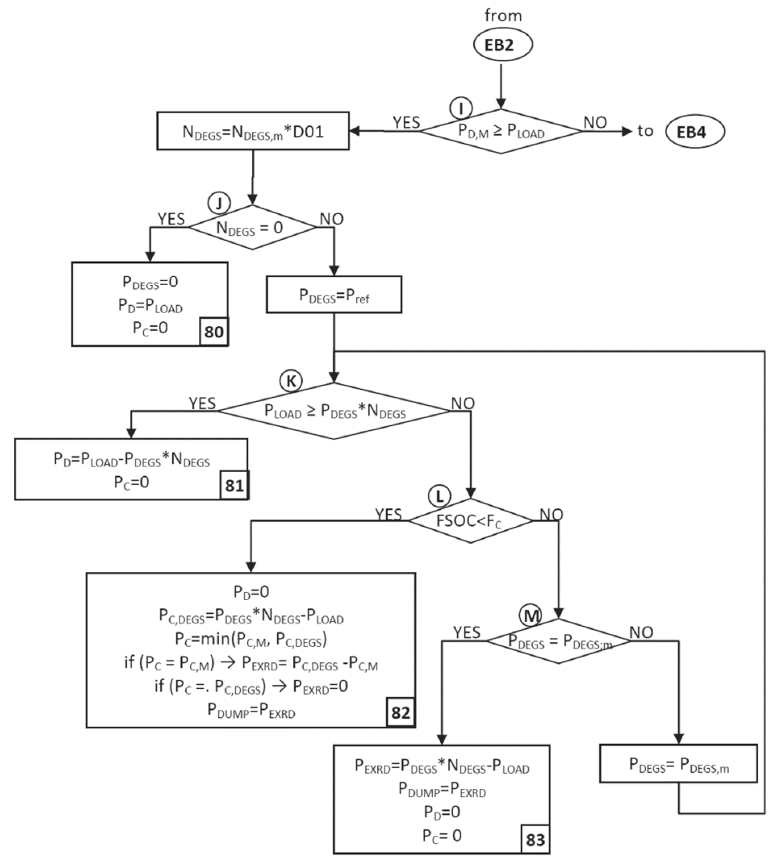
Figure 7. Control logic flow chart—evaluation block EB3.